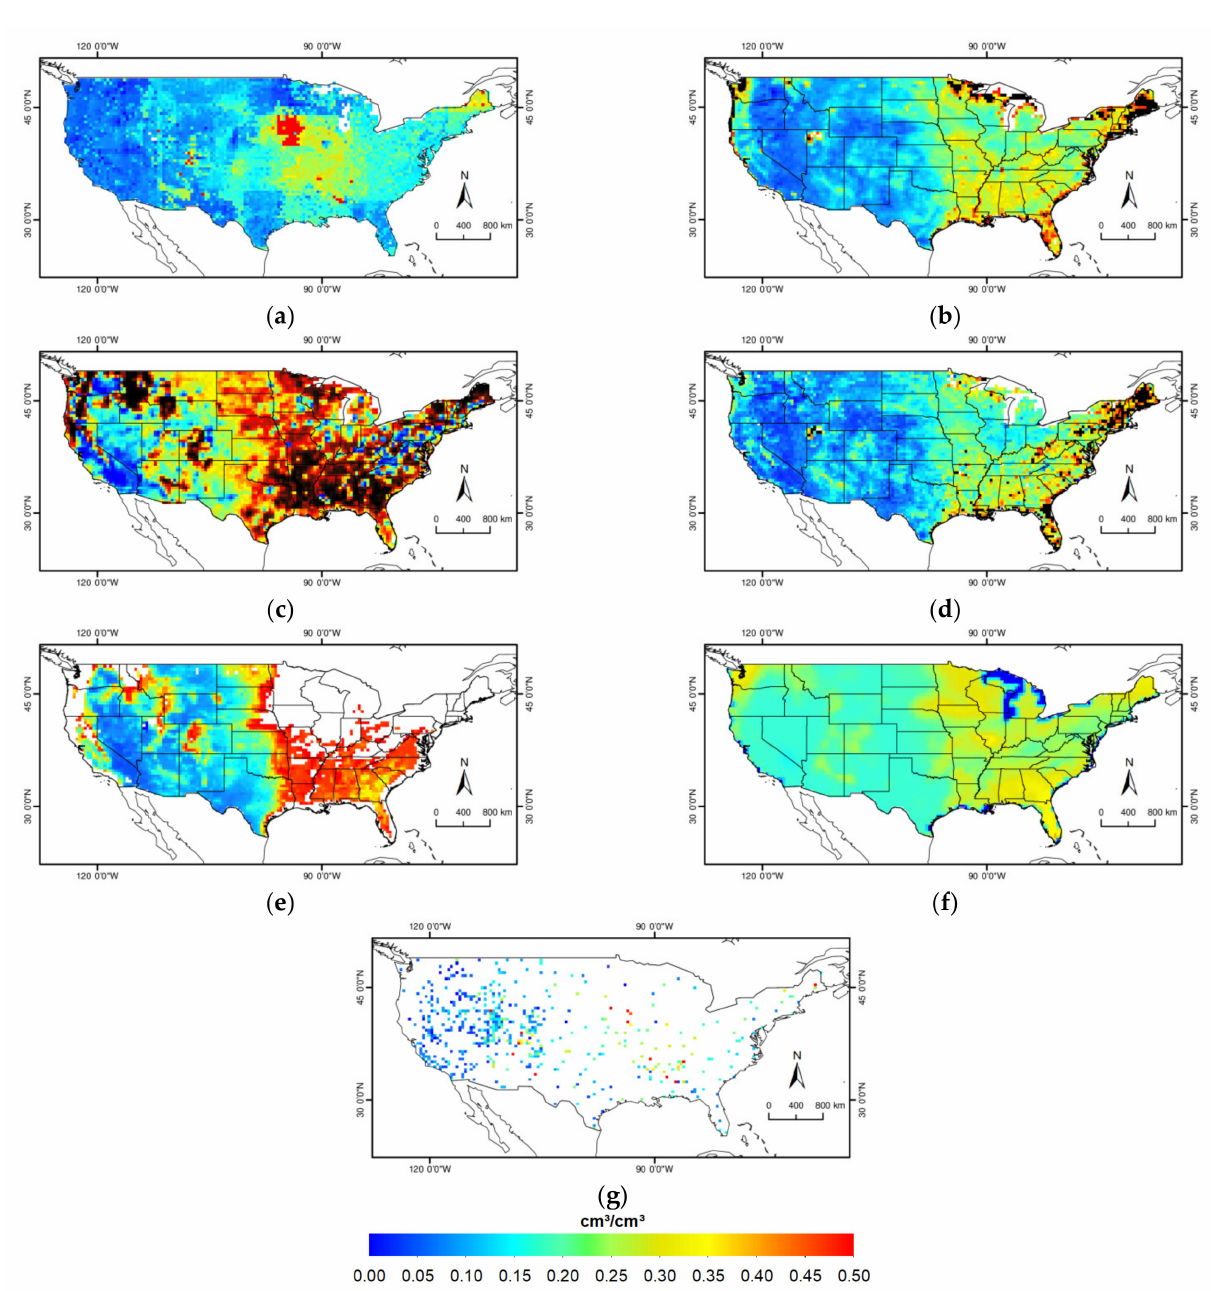
Figure 13. Mean SM maps of August 2015 for ( a ) Multi-MDA-RF, ( b ) SMAP, ( c ) AMSR2, ( d ) SMOS, ( e ) FY-3B, ( f ) ERA-Interim, and ( g ) in-situ measurements. Black pixels are considered as